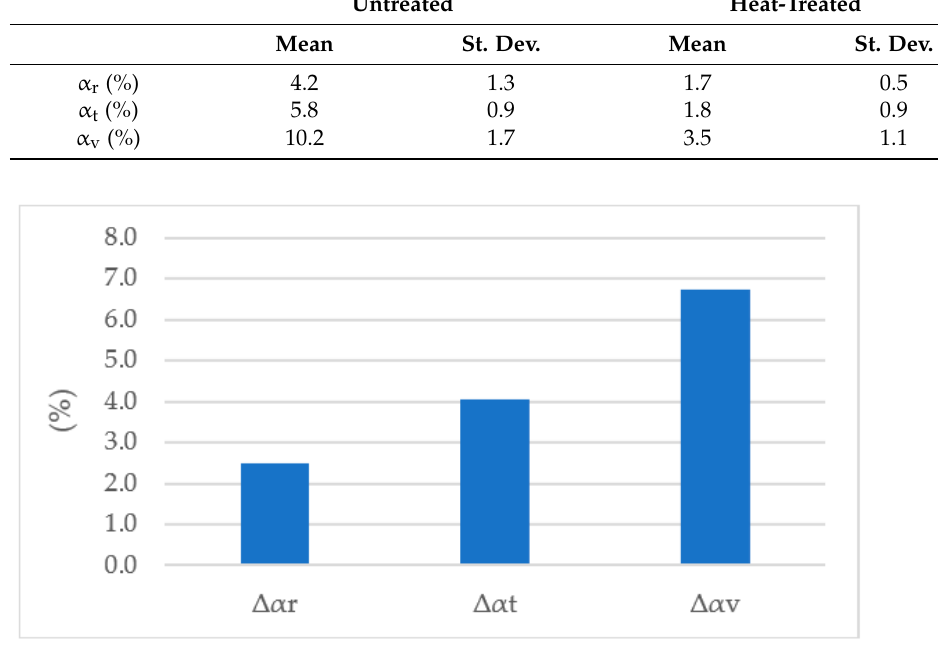
Figure 1. Difference ( Δ ) between the swelling values before and after the treatment.